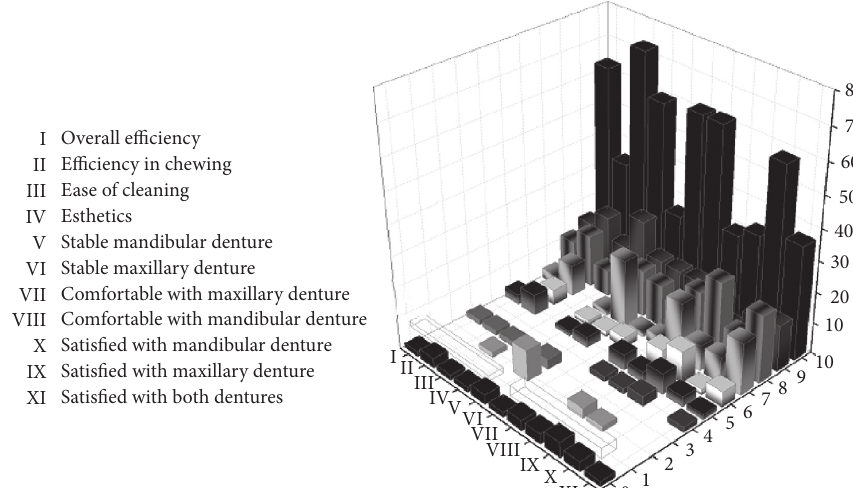
Figure 1: Percent distribution of the frequencies of the variables assessed by the patients in the 100mm VAS scale.